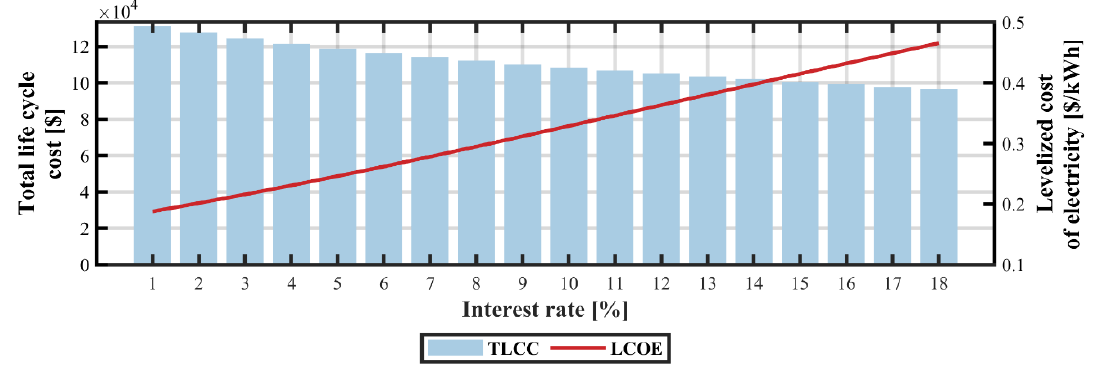
Figure 22. Simulation results of interest rate variation. Impact on LCOE and TLCC.